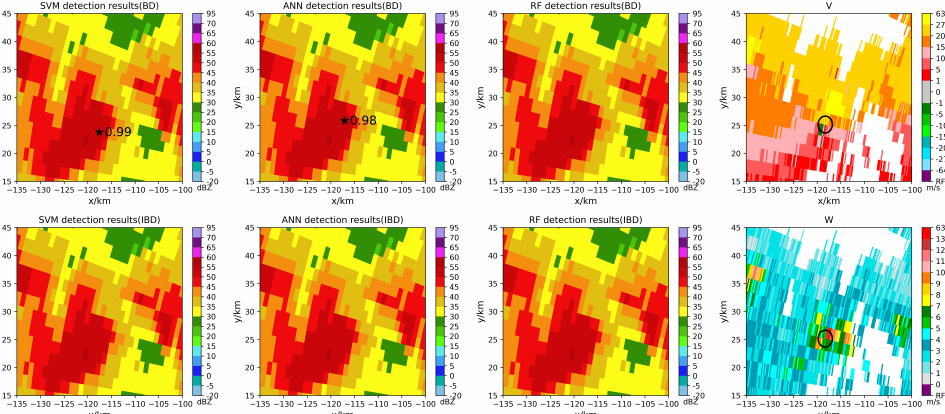
Figure 9. The tornado identification results of models at 18:45 (Beijing time, UTC+8) 0.5-degree (the black circle centered at the tornado location with a radius of 1.5 km, the SVM, ANN, RF represent Support Vector Classifier, Artificial Neural Network Classifier, Random Forest Classifier, the V represents Doppler Velocity, and the W represents Doppler Velocity Spectral Width. The BD indicates that the classifier was formed on a balanced tornado dataset, and the IBD indicates that the classifier was formed on an imbalanced tornado